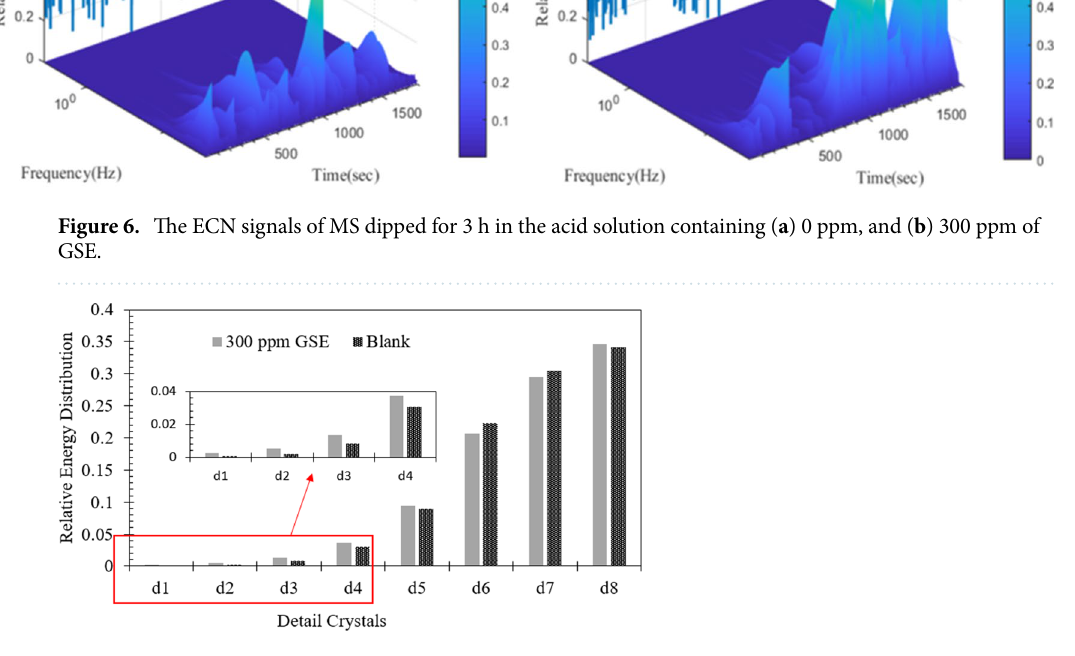
Figure 7. Energy distribution of d-crystals of current noise signals for the MS specimens in the presence and absence of